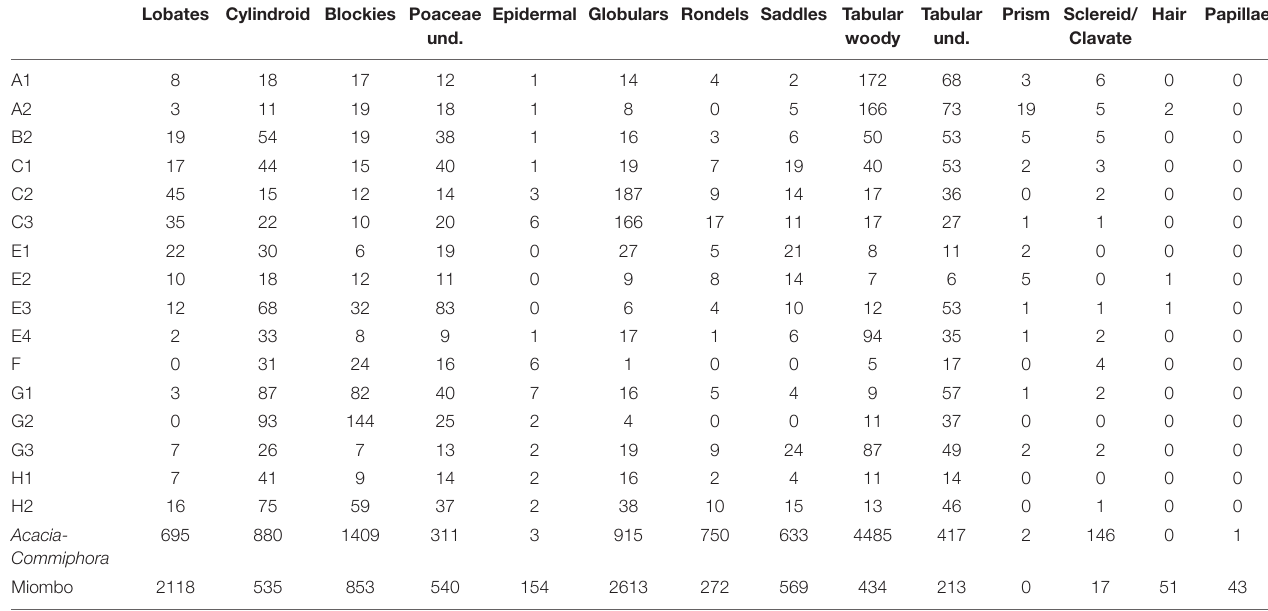
TABLE 4 | Distribution of phytolith classes. Lobates Cylindroid Blockies Poaceae